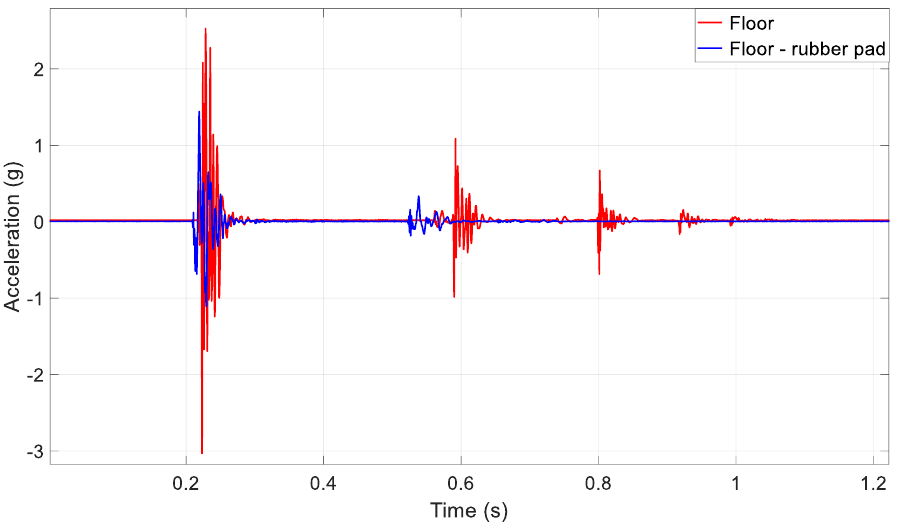
Figure 8. Acceleration generated at the floor during a barrel drop of a 90 kg deadlift barbell drop.